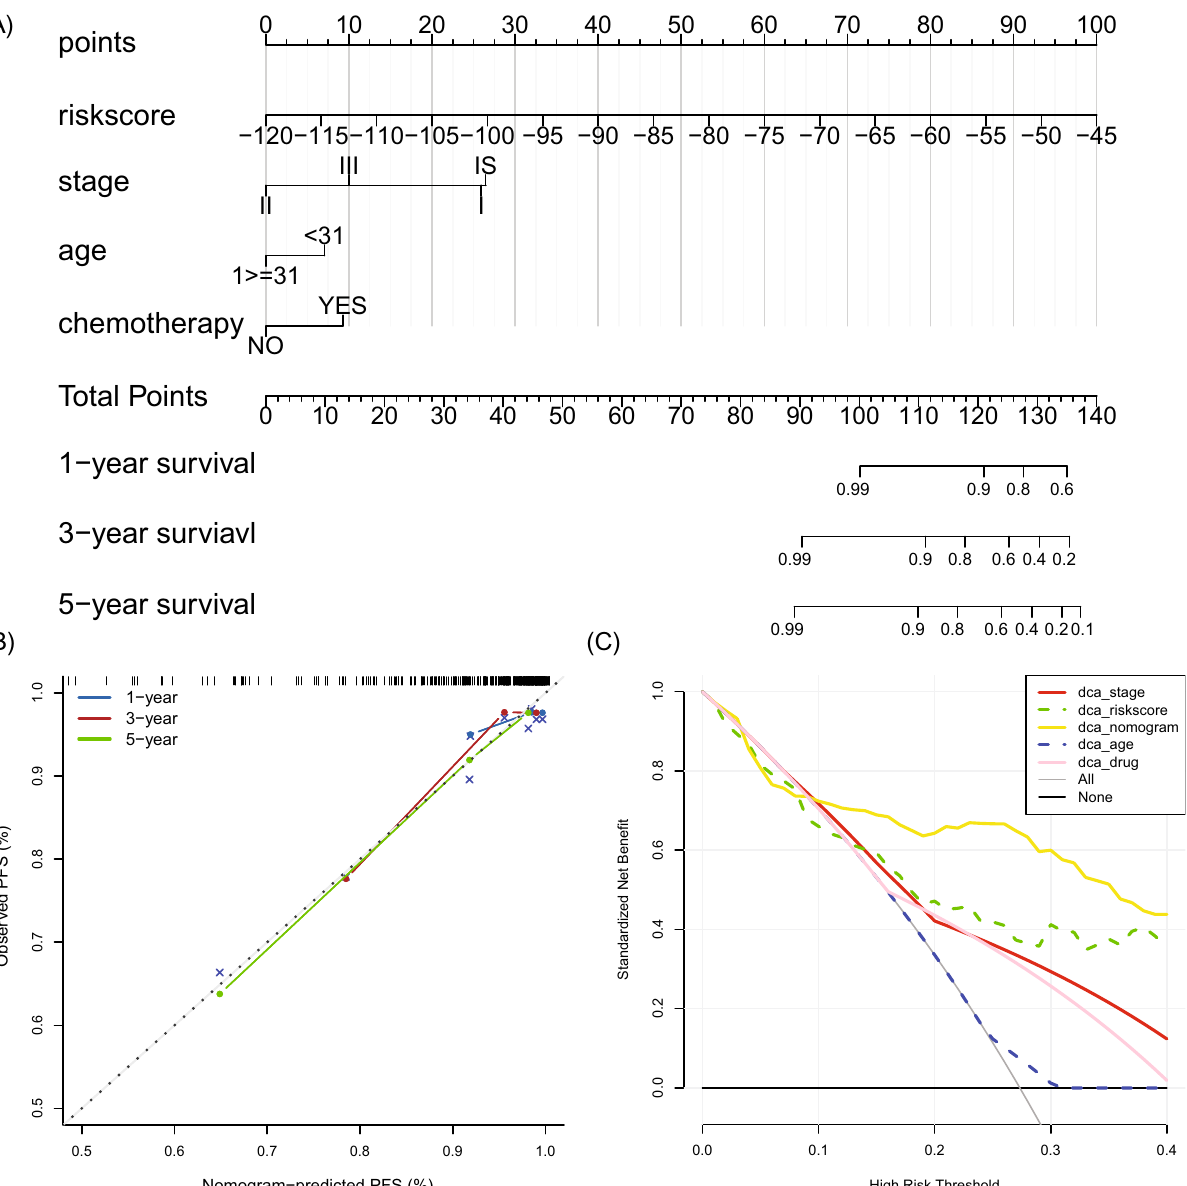
Figure 8. Construction and evaluation of a nomogram for the prediction of TGCT patients’ PFS. ( A ) The nomogram was constructed by combing the risk score, stage, age, and chemotherapy. ( B ) calibration curves of the nomogram in predicting the 1-, 3- and 5-year PFS. The closer the dotted line fit to the ideal line, the better the predictive accuracy of the nomogram is. ( C ) Decision curve analysis of the nomogram and other risk strategies in predicting the PFS of